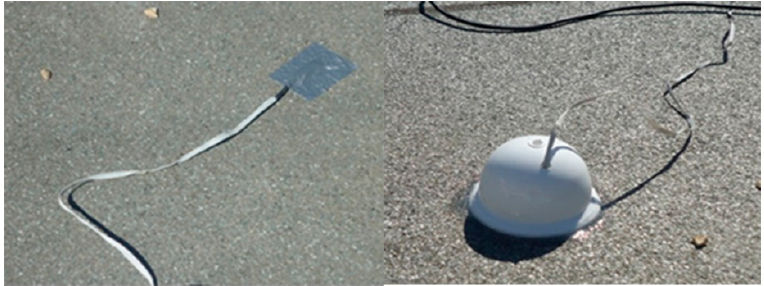
Figure 8. Detail of the protection of the contact probe on the extrados of the roof structure.